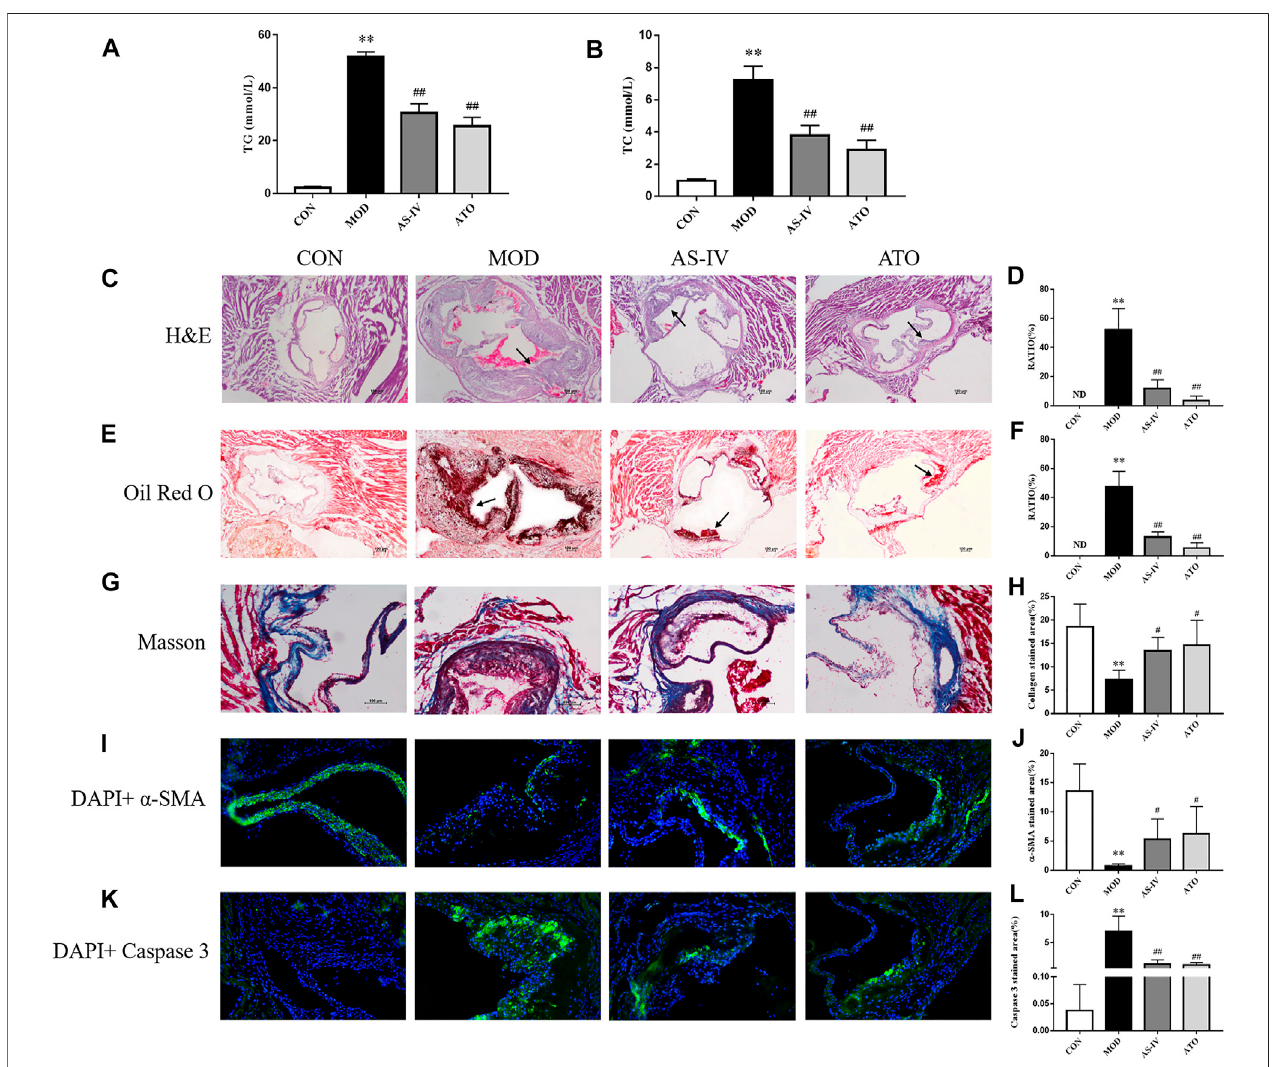
FIGURE 2 | Serumlipidpro fi lesandatherosclerosisofaorticsinusintheLDLR − / − mice. (A – B) TCandTGlevelsofserumweredetected, n =8.H&E (C) andOilRedO staining (E) were used to detect the progress of lipid-rich plaques, magni fi cation ×40, n = 6. (B,D) The areas of lesion were calculated respectively by ImageJ analysis software.Massonstaining (G) wasusedtodetectthecollagencontentfollowedbythequanti fi cation (H) ,magni fi cation×100, n =6. (I – L) Representativephotomicrographs of aortic root sections stained with α -SMA (I) , and caspase 3 (K) in atherosclerotic plaque followed bythe quanti fi cation (J,L) , magni fi cation ×200, n = 6. CON means control group, MOD means model group, AS-IV means Astragaloside IV group, ATO means Atorvastatin group. TC, total cholesterol; TG, triglyceride; ND, not detected; RATIO = plaque area/aortic sinus lumen area ×100%. Data are expressed as mean ± SD. ** p < 0.01 versus CON group; # p < 0.05, ## p < 0.01 versus MOD group.